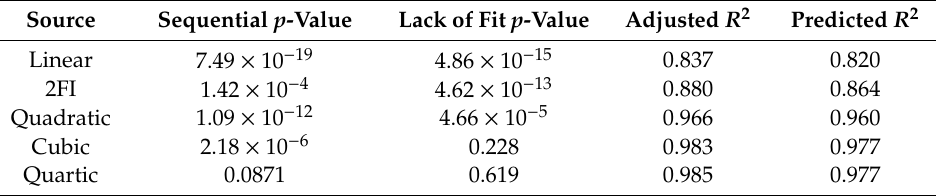
Table 5. Summary of comparison between models for A obtained from the